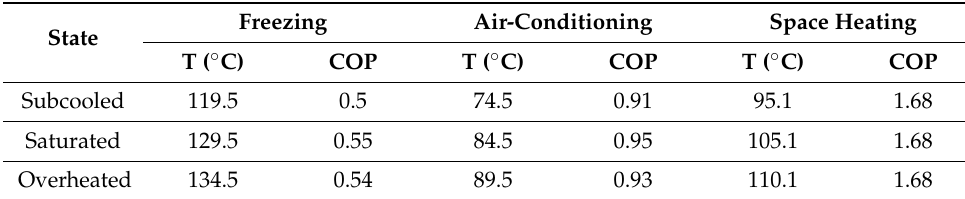
Table 5. Effects of the feed state on the system performance of the system.